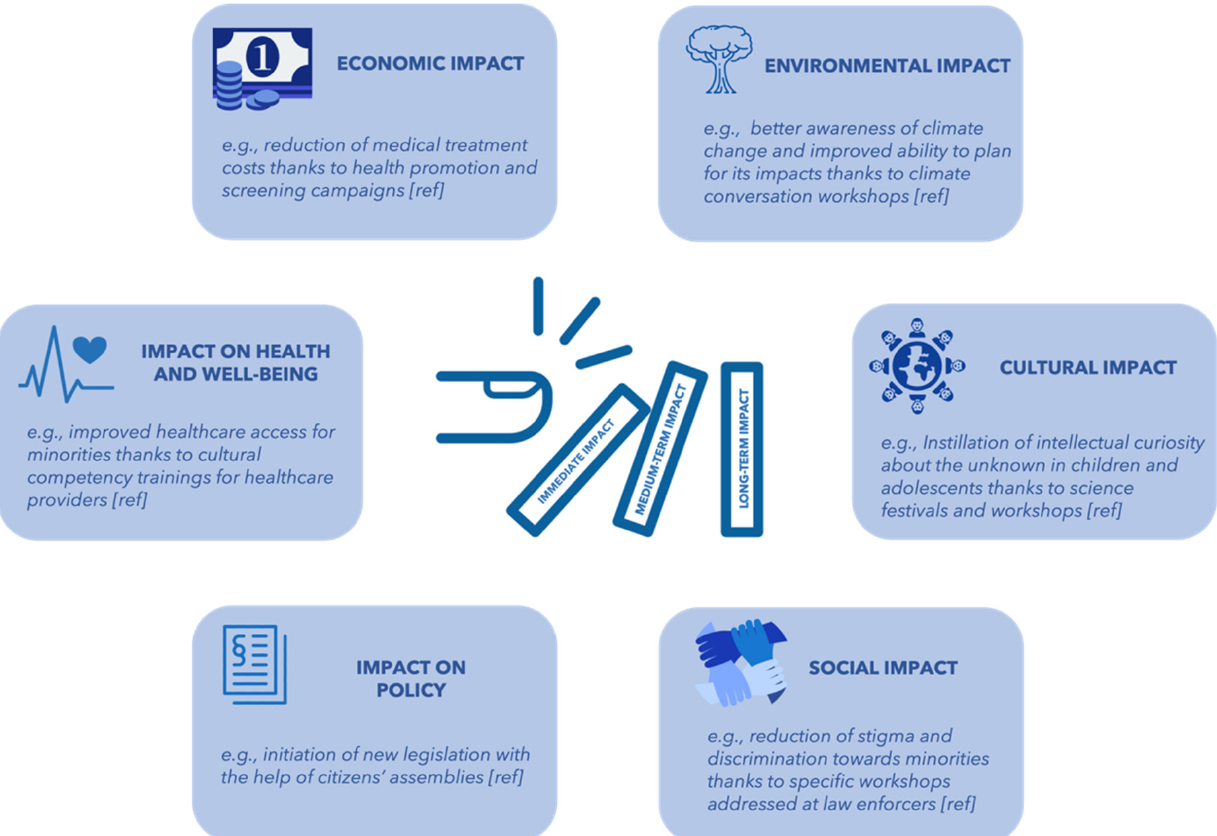
Figure 4. Areas potentially impacted by public engagement interventions. Note: the money icon was made by Paomedia (https://www.iconfinder.com/icons/299107/money_icon), the environment icon was made by Maxicons (https://www.iconfinder.com/icons/5360441/environment_forest_nat- ural_nature_tree_wood_icon), and the colors were modified by the authors of this paper. Accessed on 30 May